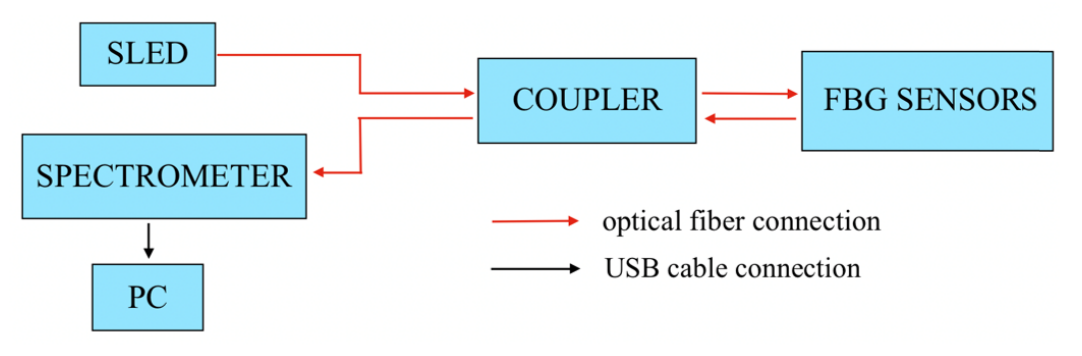
Figure 2. Schematic view of the system: light from SLED travels to the FBG sensors and reflects back to the spectrometer through a coupler for decoding and measurement in